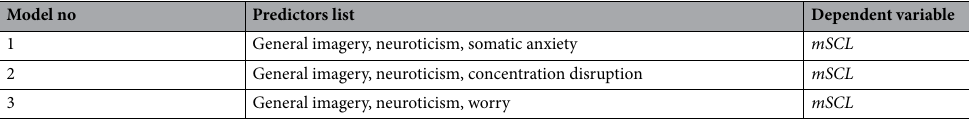
Table 5. Particular models definitions. The choice of three independent models with three predictors each (instead one model with 5 predictors) allows for better overfitting prevention, and facilitates interpretation and visualization of the prediction results,